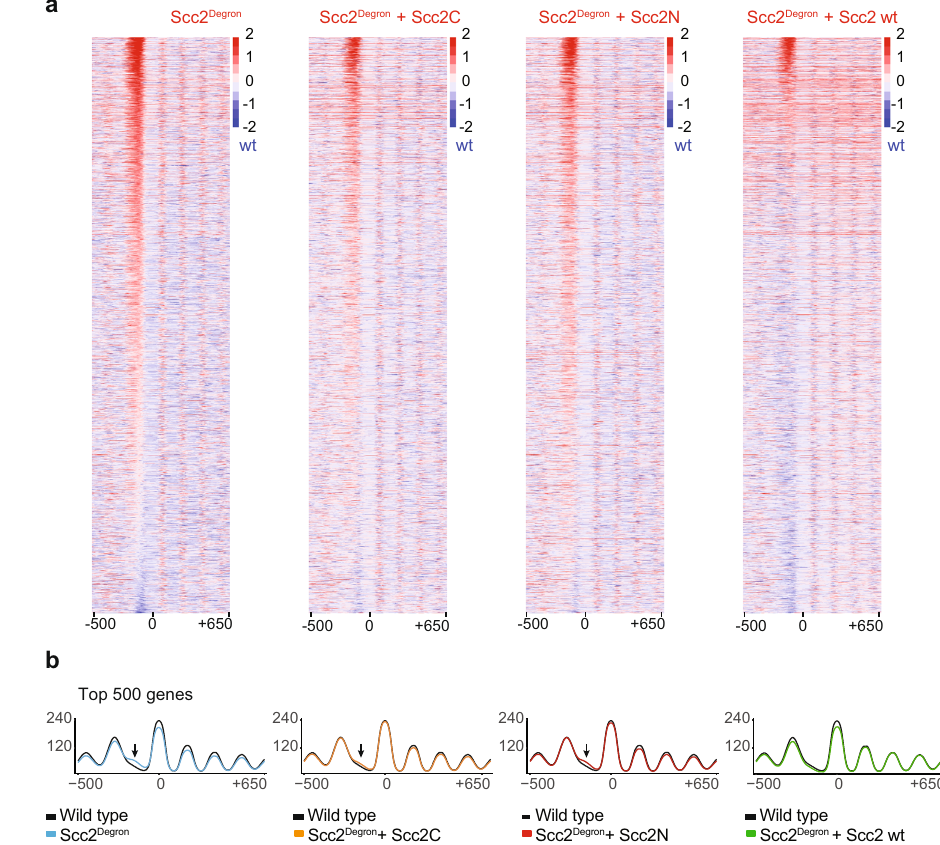
Fig. 4 | Promoter nucleosome eviction by the cohesin loader. a Differential nucleosome positioning heat maps, centered on the +1 nucleosome midpoint, comparing the indicated conditions to a wt control strain (scale, log 2 ). b Average nucleosome occupancy pro fi les at the 500 gene promoters that showed the greatest difference (within a − 150 to − 50 interval) between degron and wild type.